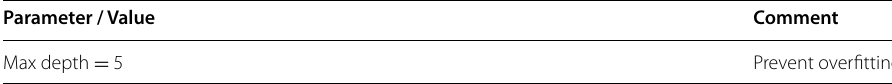
Table 5 Decision Tree classifier